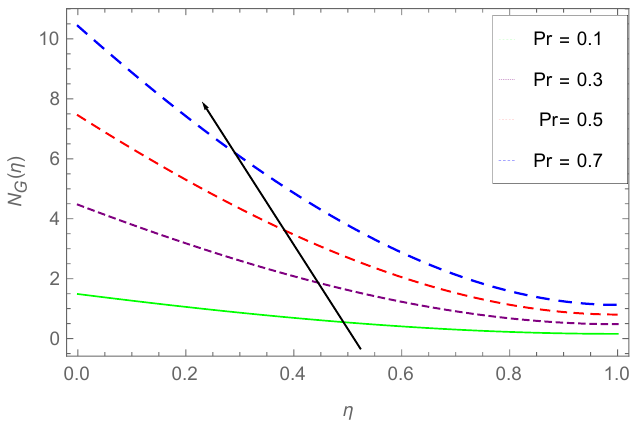
Figure 21. Variations in the function of entropy N G ( η ) for unlike values of Pr , when Br = 0.3, R e = 0.7, Rd = 0.7 and M = 0.9.